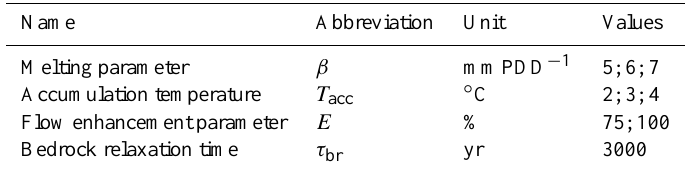
Figure 7. Structured parameter tree for the distribution of the minimum sea level with respect to the influence of each tuning parameter. Each layer is represented by a tuning parameter; the number of different tuning parameter values is shown on the right y axis. The gray horizontal bar corresponds to the sea level decrease in the LGM in the Northern Hemisphere from Clark and Mix (2002). Table 5. Subset of tuning parameters with 18 members and their used values for a hysteresis ensemble (Fig.